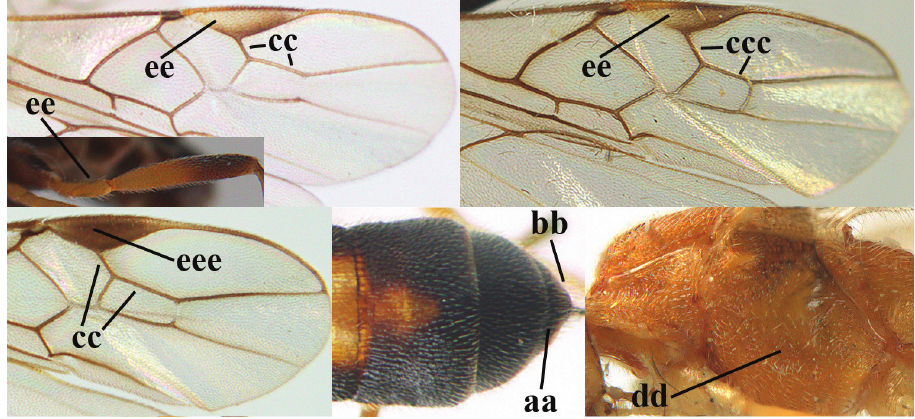
trochantelli usually brownish yellow (ee) and colour of pterostigma variable (ee, eee) .....................................................................................................